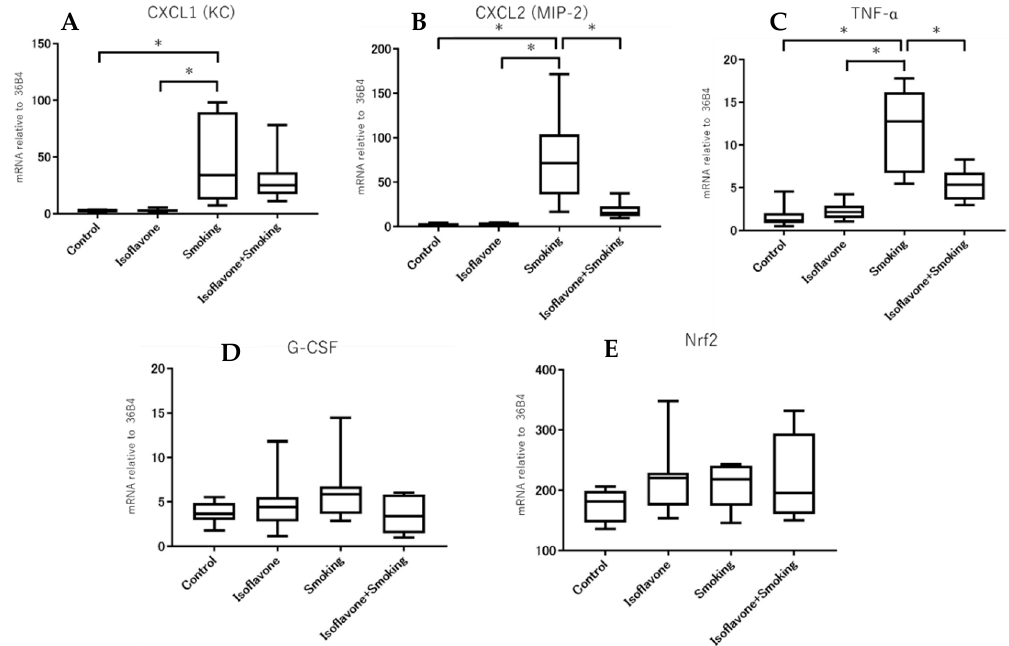
Figure 4. Relative mRNA level of each cytokine, chemokine and Nrf2. The mRNA level of ( A ) CXCL1 (KC), ( B ) CXCL2 (MIP-2), ( C ) TNF- α , ( D ) G-CSF, and ( E ) Nrf2 are shown. Cigarette smoke exposure increased gene-expression of TNF- α , CXCL1 (KC), and CXCL2 (MIP-2). Isoflavone significantly decreased the cigarette smoke-induced TNF- α and CXCL2 (MIP-2) gene expression. Data are shown with box and whisker plots. * p < 0.05.